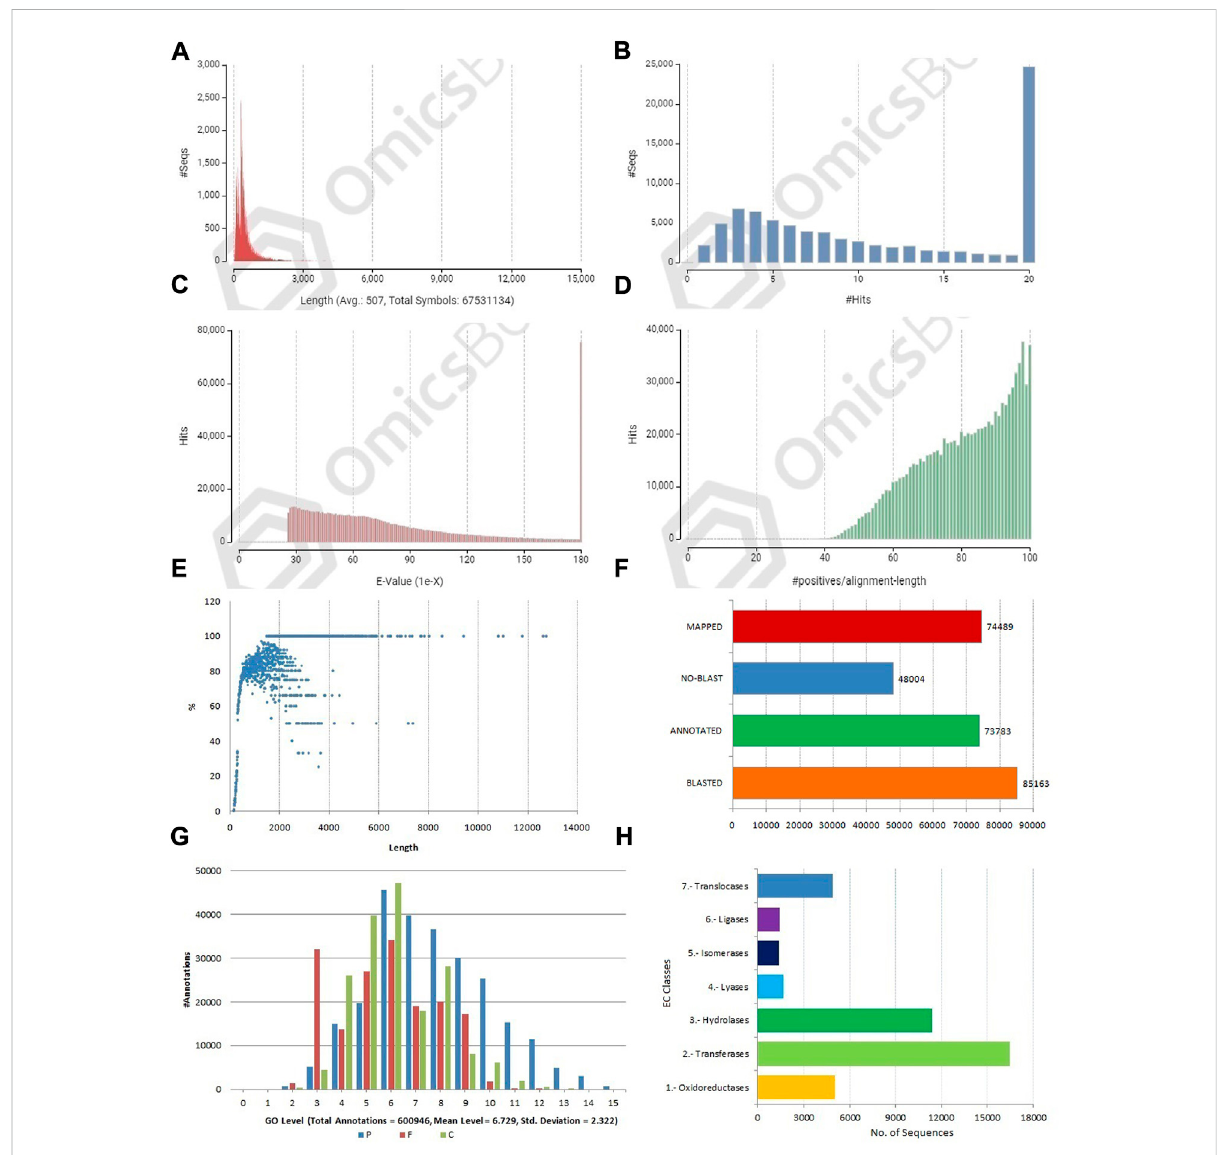
FIGURE 3 Structural and functional annotation of allohexaploid transcriptome assembly. (A) Sequence length distribution of coding sequences; (B) BLASTX hit distribution; (C) E-value distribution; (D) Sequence similarity distribution of BLASTX hits; (E) Annotation percent of coding sequences against length. (F) Three-step distribution of OmicsBox process (BLASTX, mapping, and annotation); (G) GO level distribution for biological process, molecular function, and cellular component [P-BP, F-MF, and C-CC]; (H) Enzyme code distribution for major